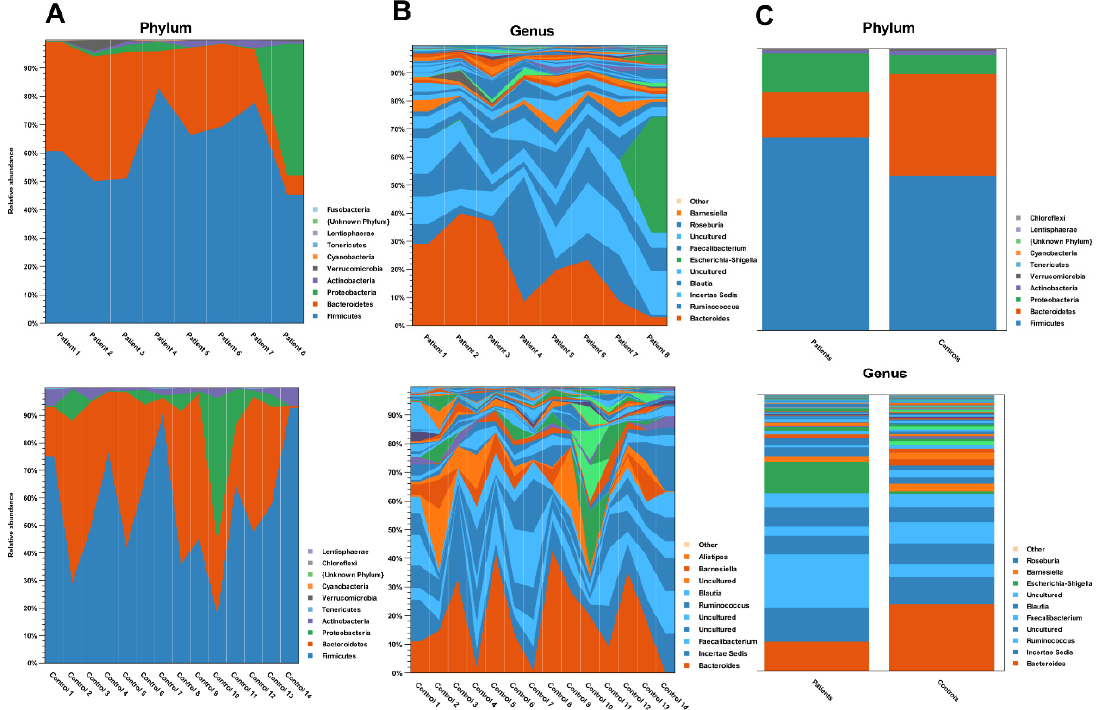
Figure 2. Individual ( A , B ) and group ( C ) profiles of gut microbial composition at the phylum and genus level in the COVID-19 patient and healthy control groups. Charts for group profiles show mean relative abundance.